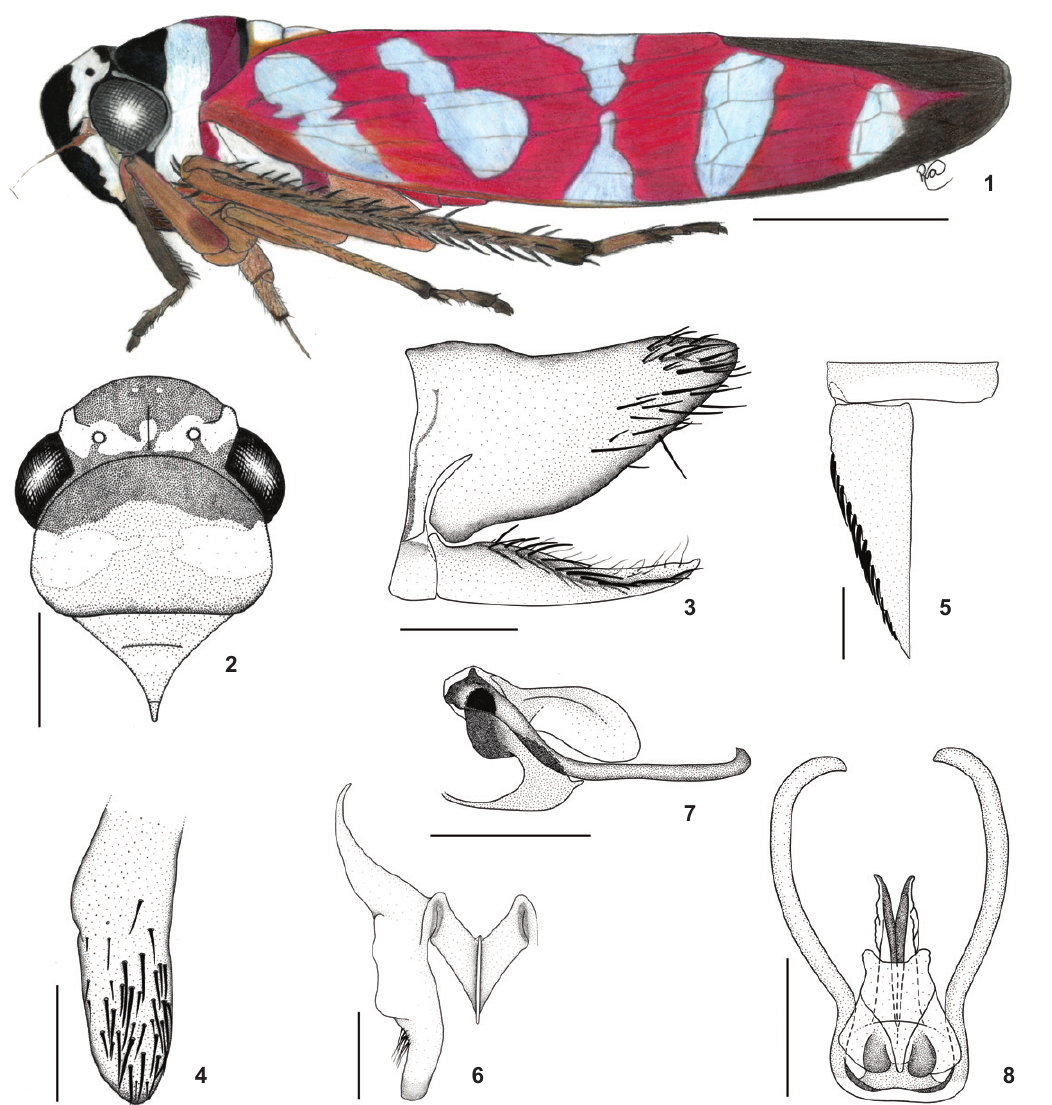
Figures 1-8. Ruppeliana caelimaculata sp. nov. , male holotype: (1) body in lateral view; (2) anterior dorsum; (3) pygofer, valve and subgenital plate, lateral view; (4) pygofer apex, ventral view; (5) valve and subgenital plate, ventral view; (6) connective and style, dorsal view; (7, 8) aedeagus and its processes in lateral (7) and ventral (8) view. Scale bars: 1 = 2.0 mm; 2 = 1.0 mm; 3, 4, 5, 7, 8 = 0.5 mm; 6 = 0.2